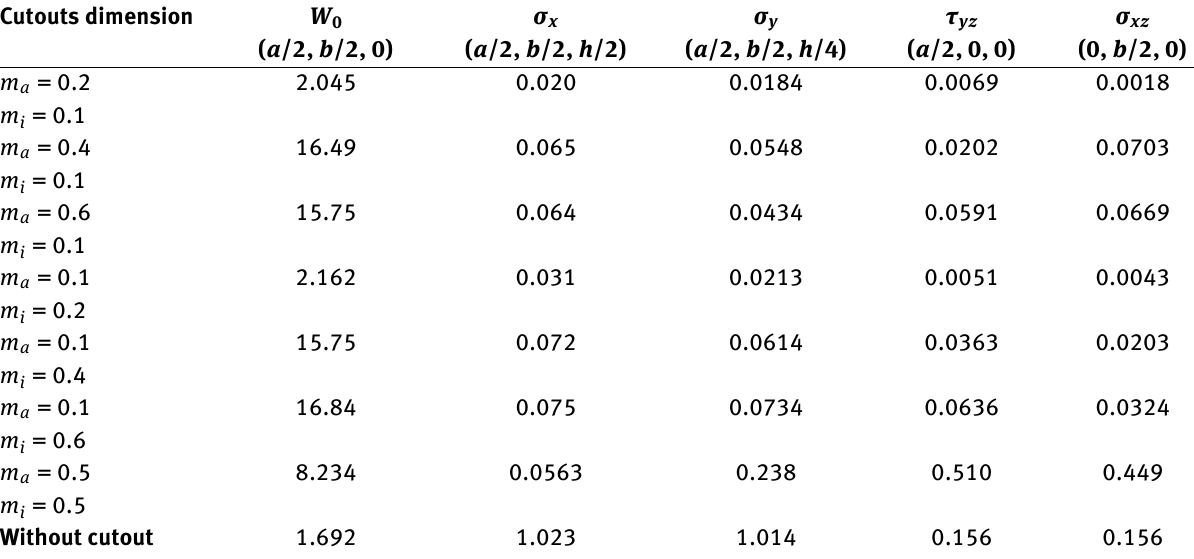
Table 10: Effect of cutout dimensions with various stresses the central deflection of simply supported (S2) laminated (0/90/C/90/0) sand- wich square plate under